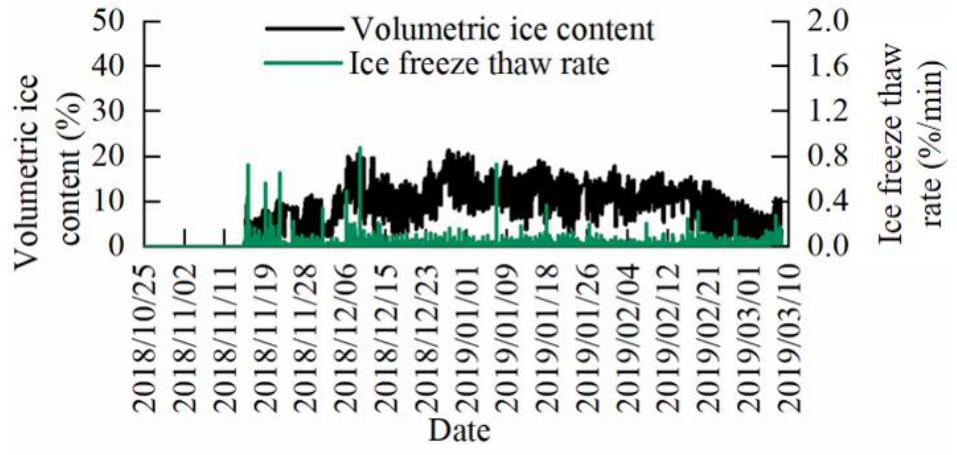
Figure 16. The variation of volumetric ice content and the ice freeze-thaw rate of the branches of Lagerstroemia indica L.